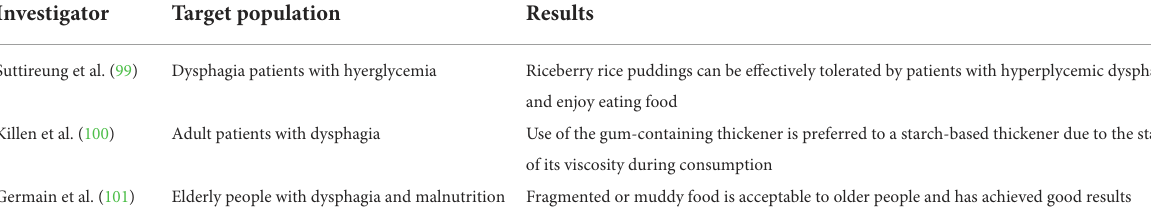
TABLE 3 Summary of food products suitable for Non-OD